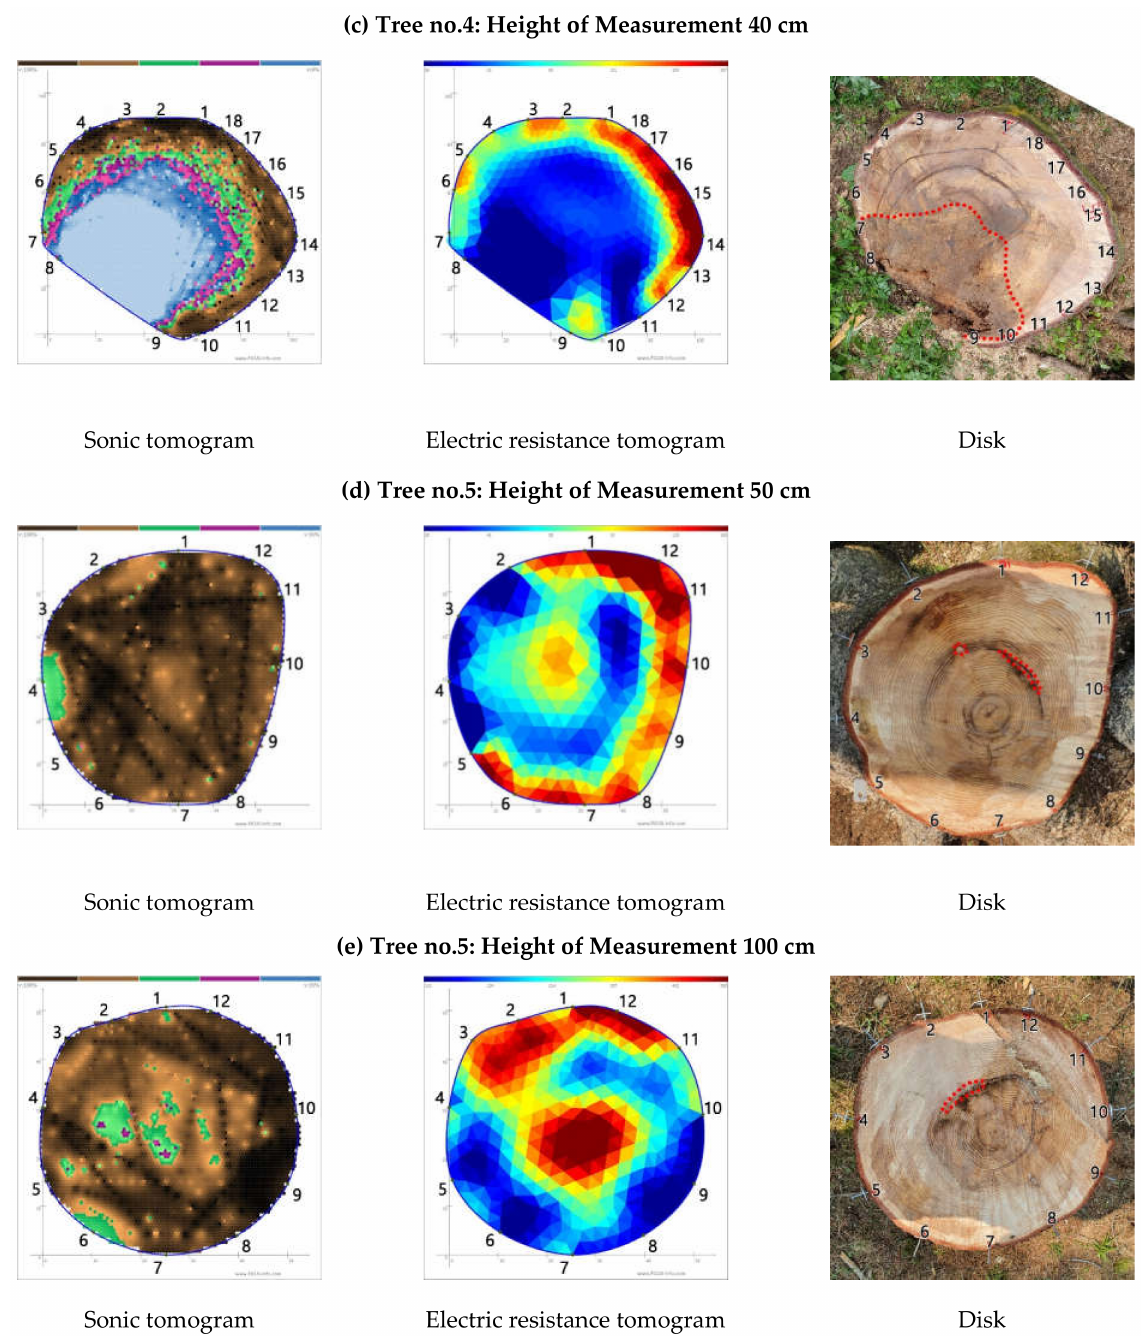
Figure 3. Comparison of the sonic tomograms and ERT tomograms images and the tree cross section (the red dotted lines indicate the decay area). In the sonic tomograms, brown: healthy wood, red and blue: defects, green: initial decays; in the ERT tomograms, blue: high water content, red: lower water content, green and yellow: decreasing water